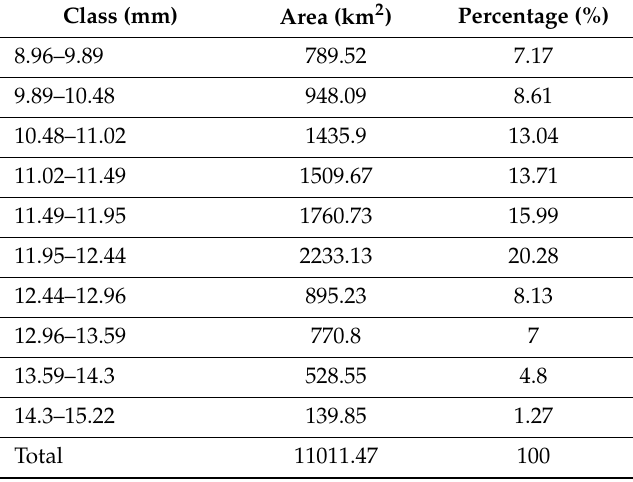
Table 16. Rainfall density analysis for Al-Shamal train pathway in Al-Qurayyat city in